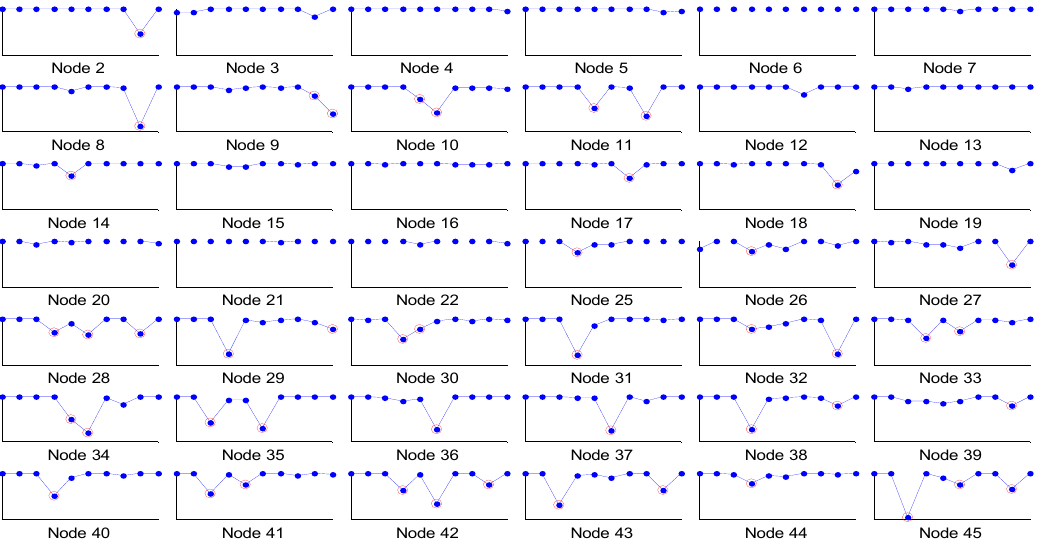
Figure 8. Phase angles of each node in the bridge. x -axis is the mode number from 1 to 10 and y -axis is the absolute value of cosines of phase angles ranging from 0 to 1.0. The points in red circles are the “outliers”, that is, values of less than 0.80.